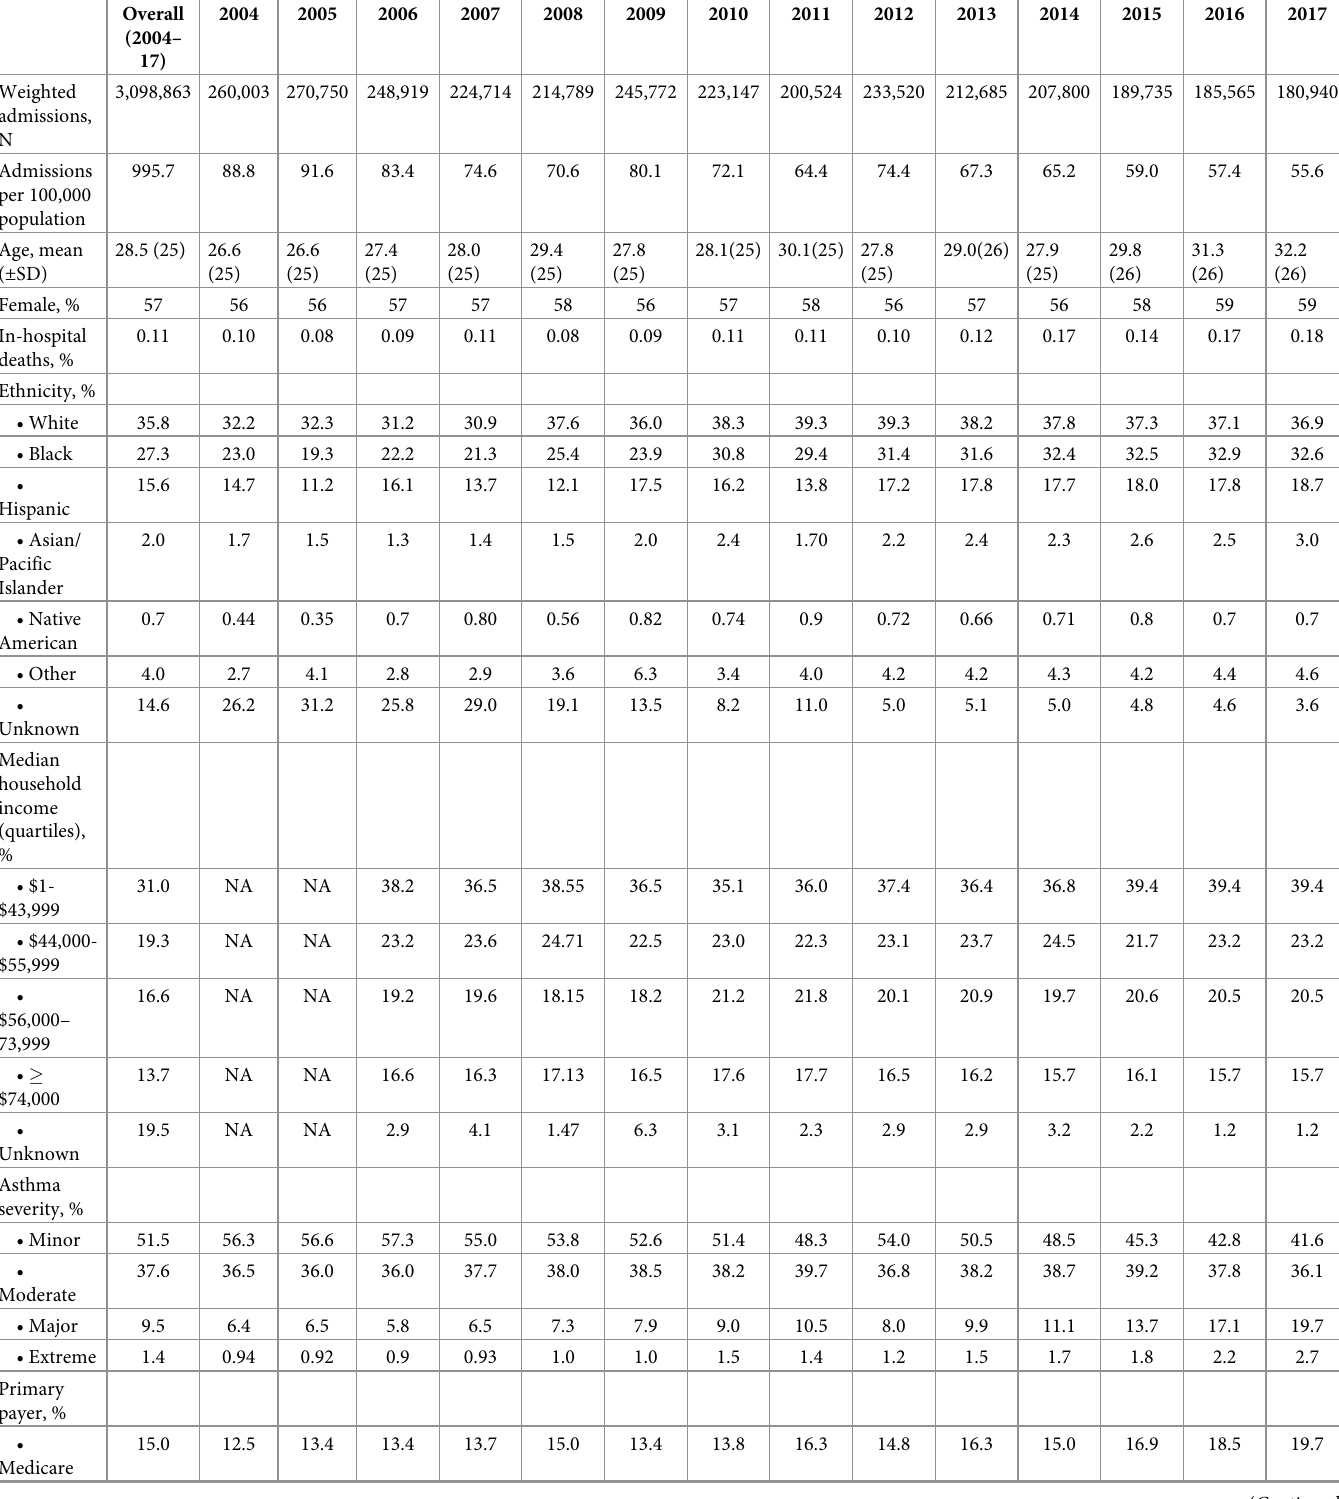
Table 1. Annual trends of admissions and baseline characteristics of patients admitted with asthma between 2004 and